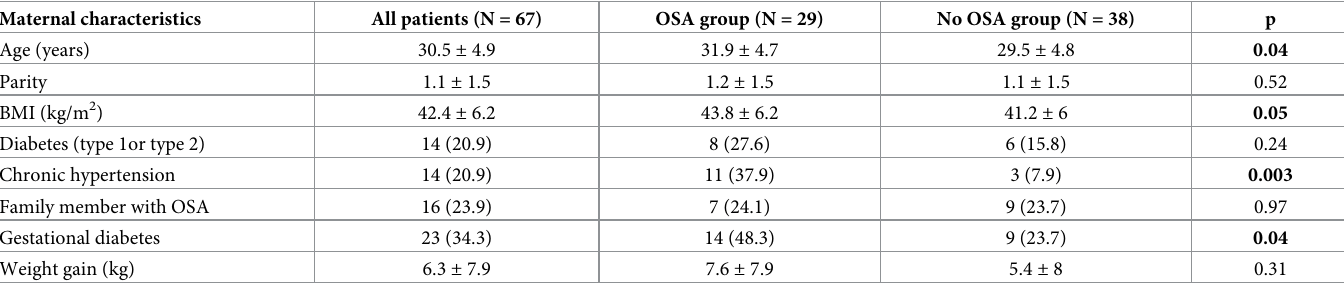
Table 1. Maternal characteristics for all patients and compared to OSA group and no OSA group to study risk factors for developing an OSA. Maternal characteristics